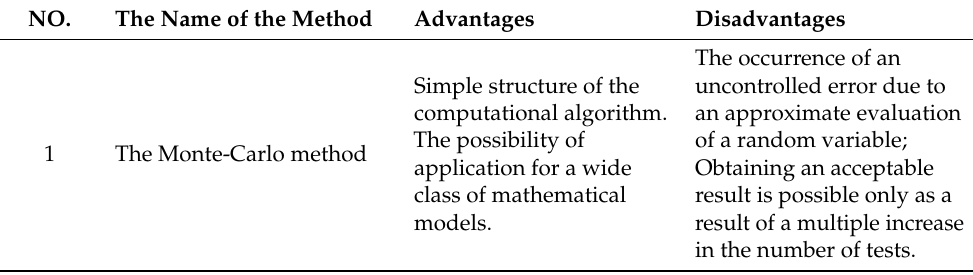
Table 1. The conventional statistical methods that are used in information processing.